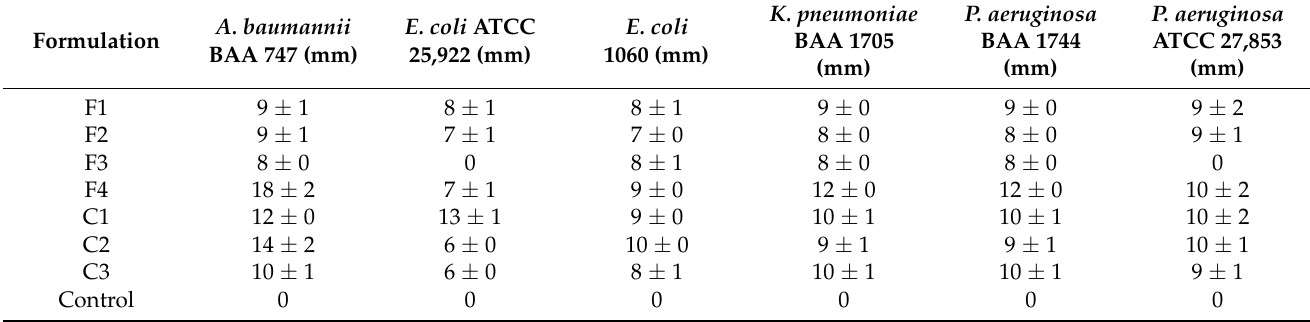
Table 5. The zone of inhibition diameters of the prepared hand sanitizers compared to three commercially available hand sanitizers (C1, C2, and C3) against gram-negative bacterial strains. The results represent the mean of three independent experiments ± SD ( n = 3). Both the clove and tea tree EO hand sanitizers showed antibacterial activities against all gram- negative strains similarly to the controls, but with variable efficacies. The oil-free control formula showed no antibacterial effect against any of the tested gram-negative